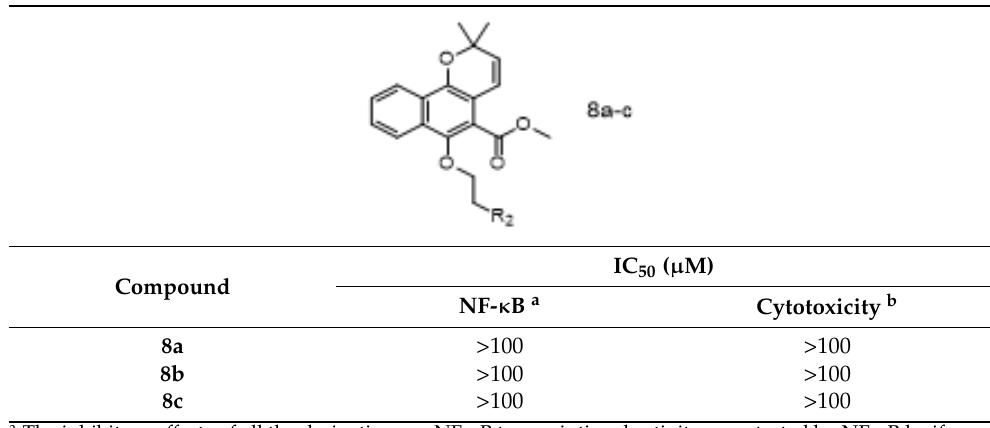
Figure 2. Effect of compound 6d on pNF- κB -mediated reporter gene expression. ( A ) HeLa cells were transiently co-transfected with a NF- κ B luciferase and pRL-CMV vectors. Following 24 h incuba- tion, the cells were incubated under hypoxia in the absence or presence of the indicated